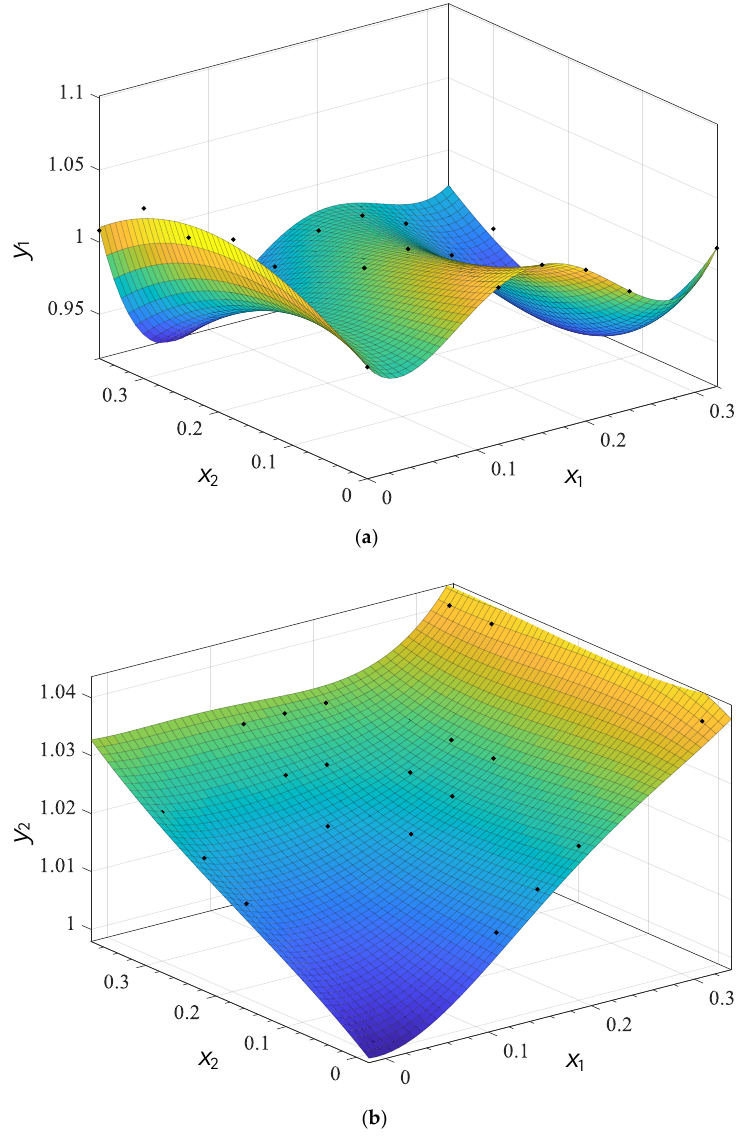
Figure 8. Fitting surface: ( a ) fitting surface of y 1 ; ( b ) fitting surface of y 2 .